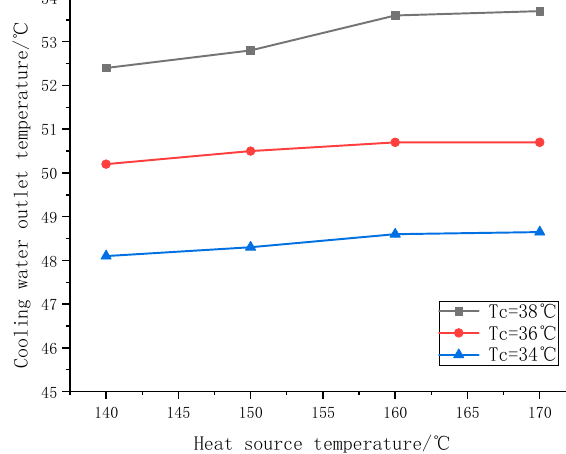
Figure 7. Effect of heat source and cooling water temperatures ( T c ) on cooling water outlet temperature.